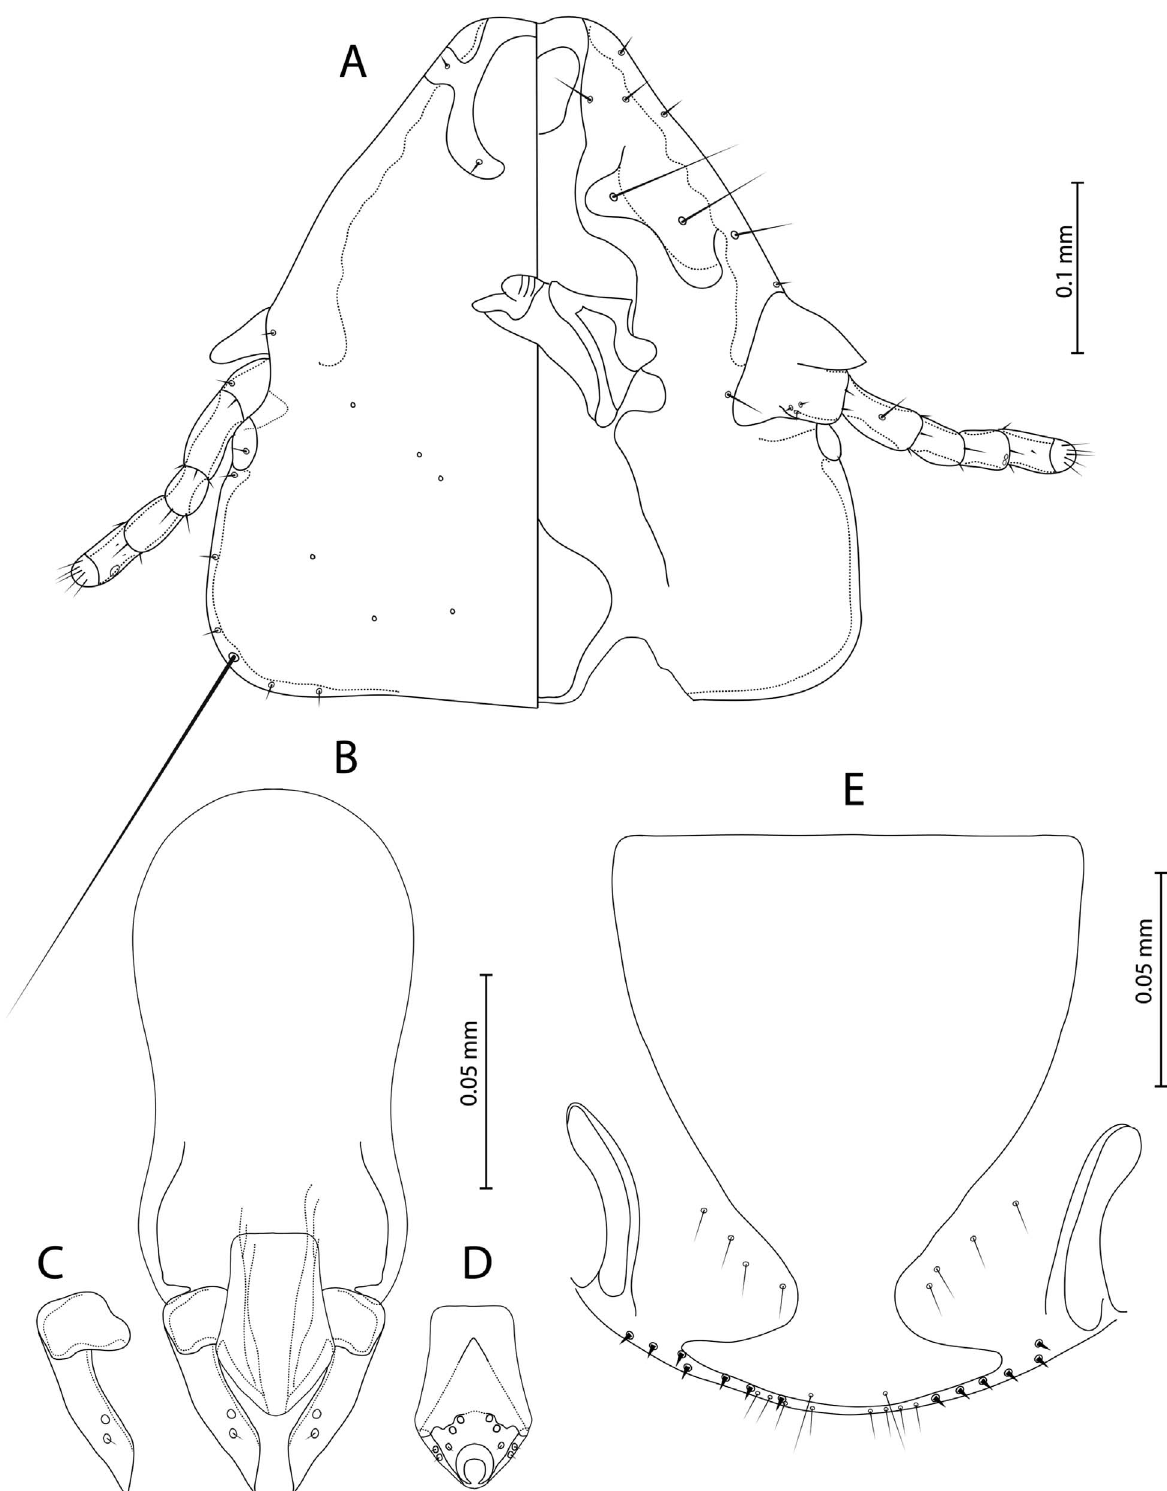
Figure 2. Guimaraesiella tovornikae ex Sylvia atricapilla . (A) Male head, dorso-ventral view; (B) Male genitalia, dorsal view; (C) Male paramere, dorsal view; (D) Male mesosome, ventral view; (E) Female submarginal plate and vulval margin, ventral Abdominal segments with well-de fi ned median gap in each row of tergal setae. Tergal setae (postspiracular setae and on tergites II – VIII also short associated setae are not included): I, 6 – 9 (8);